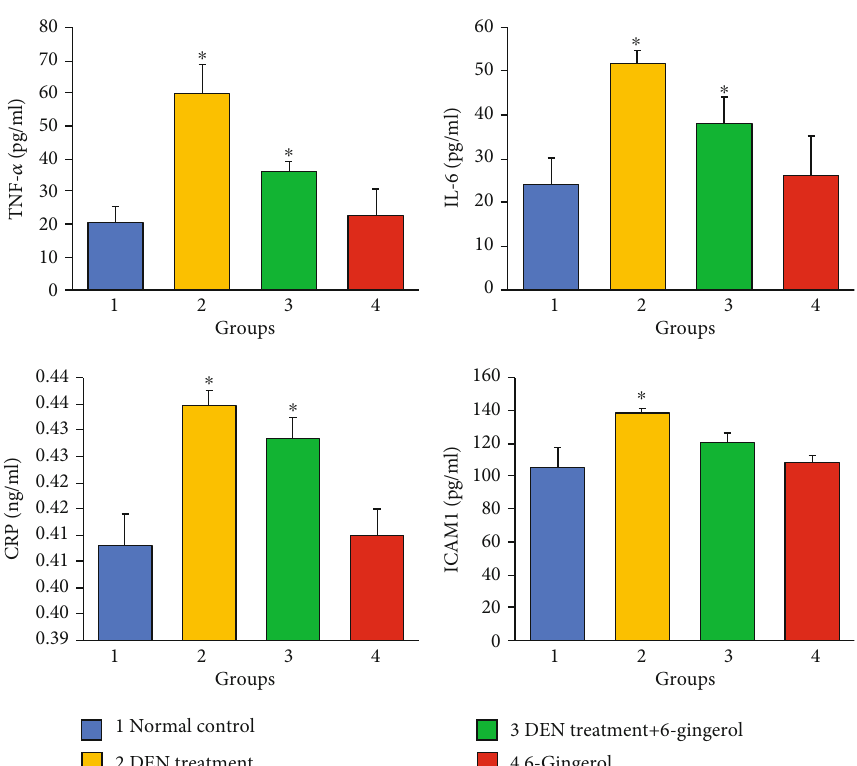
Figure 10: The e ff ect of 6-gingerol on in fl ammatory markers. The anti-in fl ammatory markers include TNF- α , IL-6, CRP, and ICAM1. In rodents, which received DEN, the levels of TNF- α , IL-6, CRP, and ICAM1 were found to be signi fi cantly increased as compared with the control group ( p < 0 : 05 ). However, the levels of these in fl ammatory markers were signi fi cantly decreased in rats administrated with both DEN and 6-gingerol ( p < 0 : 05